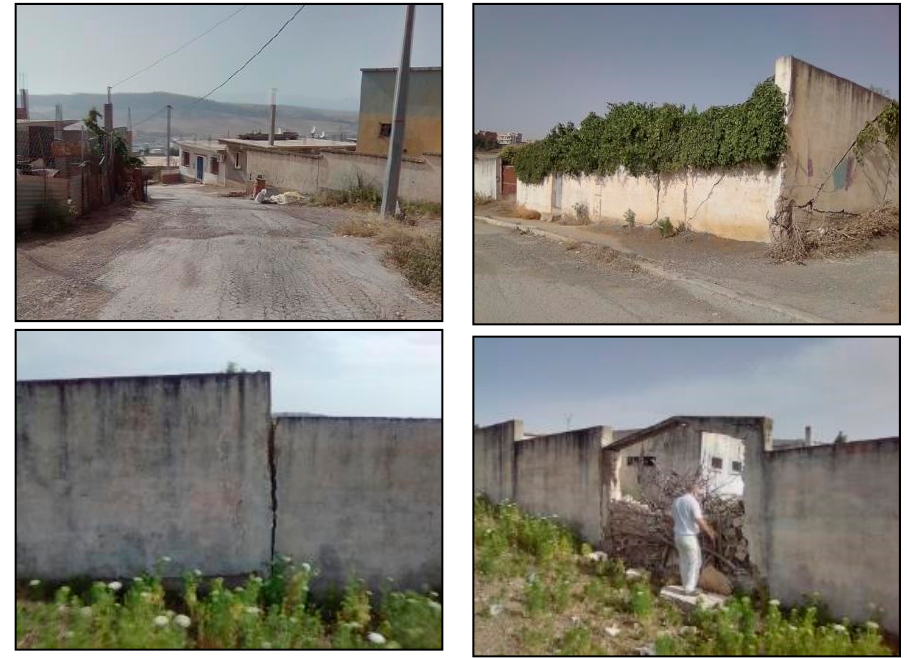
Figure 12. Landslide damage on the infrastructure in Sidi Arab (South Didouche Mourad).